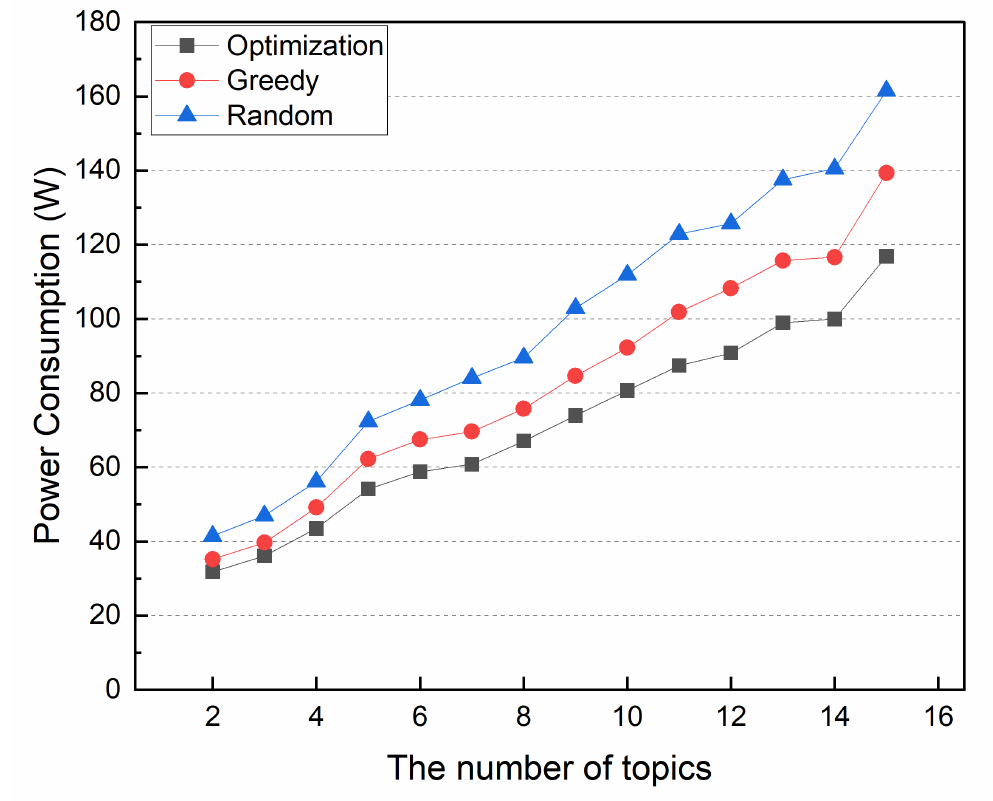
Figure 17. Power consumption according to the number of